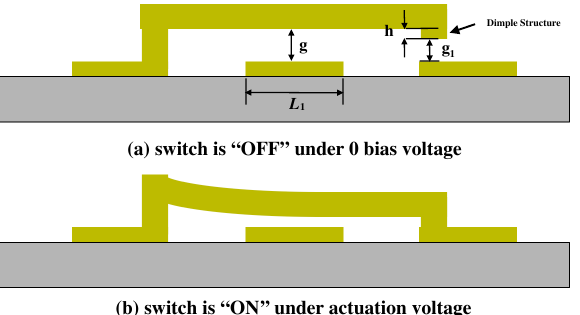
Figure 2. The OFF and ON states of the RF MEMS switch under different DC bias conditions. The cantilever to bias pad gap g and dimple to CPW distance g 1 are both marked. ( a ) The Switch is under OFF state. ( b ) The Switch is under ON